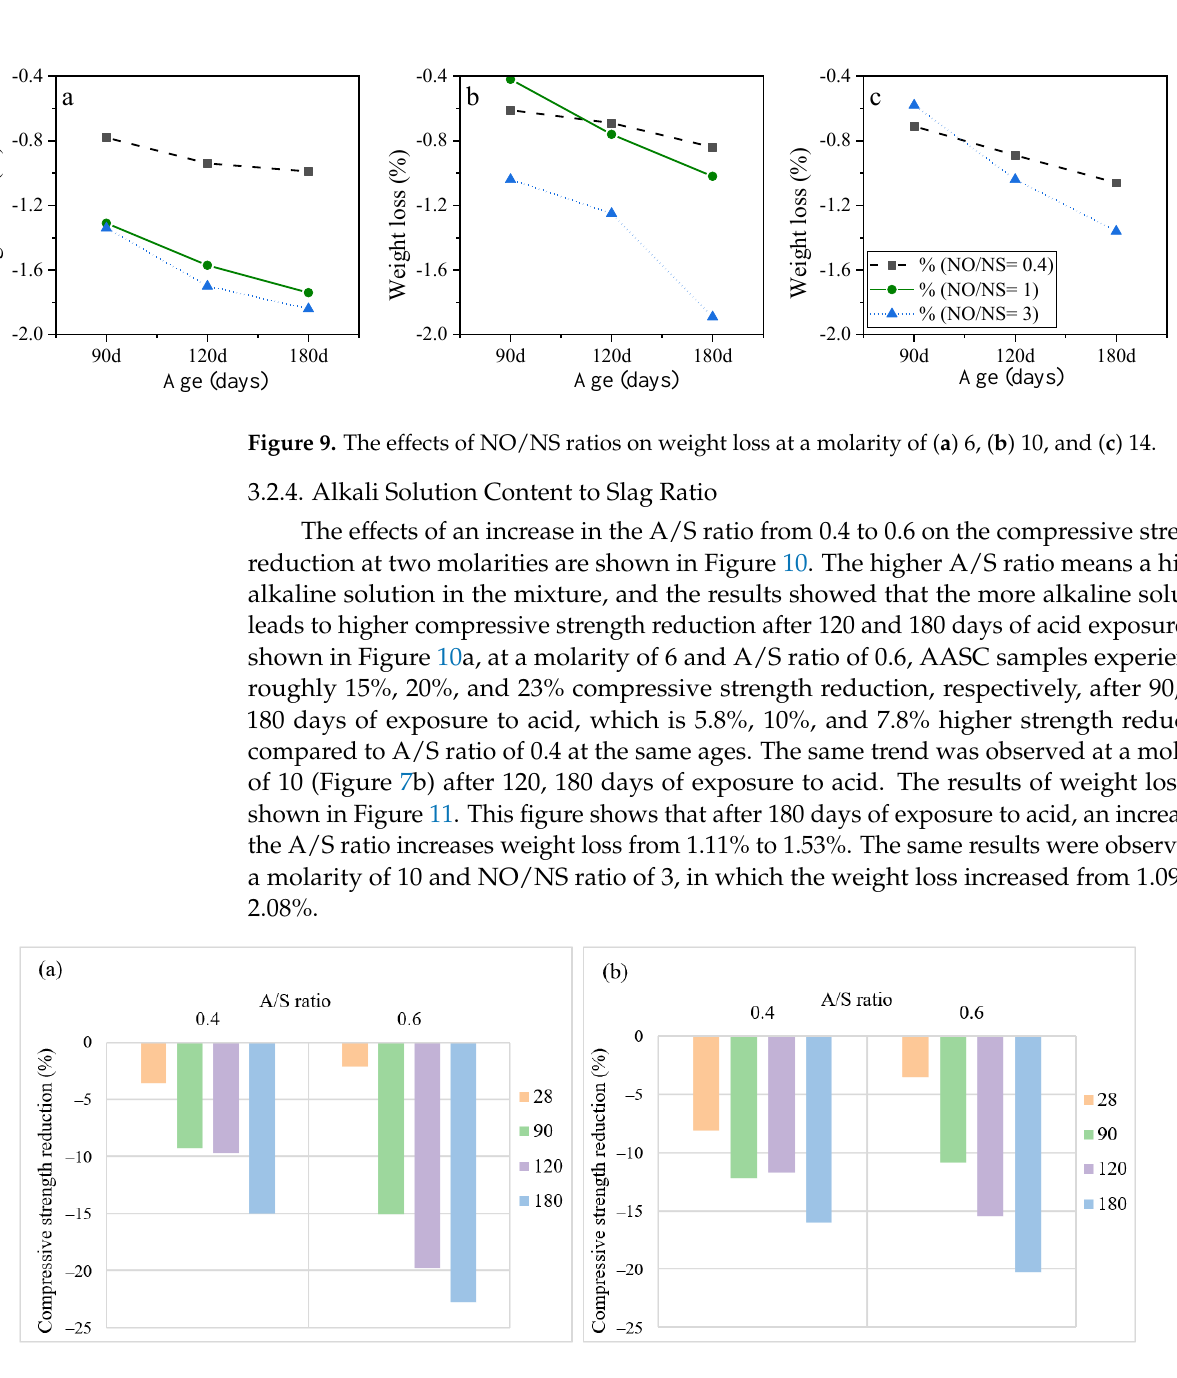
12 of 18 Figure 8. The effects of NO/NS ratios on compressive strength reduction at a molarity of ( a ) 6, ( b ) 10, and ( c ) 14. Figures 8 and 9 display the impacts of an increase in NO/NS ratio on the compressive strength reduction and weight loss reduction of AASC after acid exposure. At a molarity of 6, Figure 8a, the lowest NO/NS ratio (0.4) showed a 14.55% strength reduction after 180 days of exposure which was slightly lower than other modalities. As illustrated in Figure 8b,c, the higher NO/NS ratio resulted in higher compressive strength reduction for sam- ples with molarities of 10 and 14. Regarding weight loss, the higher NO/NS ratio results